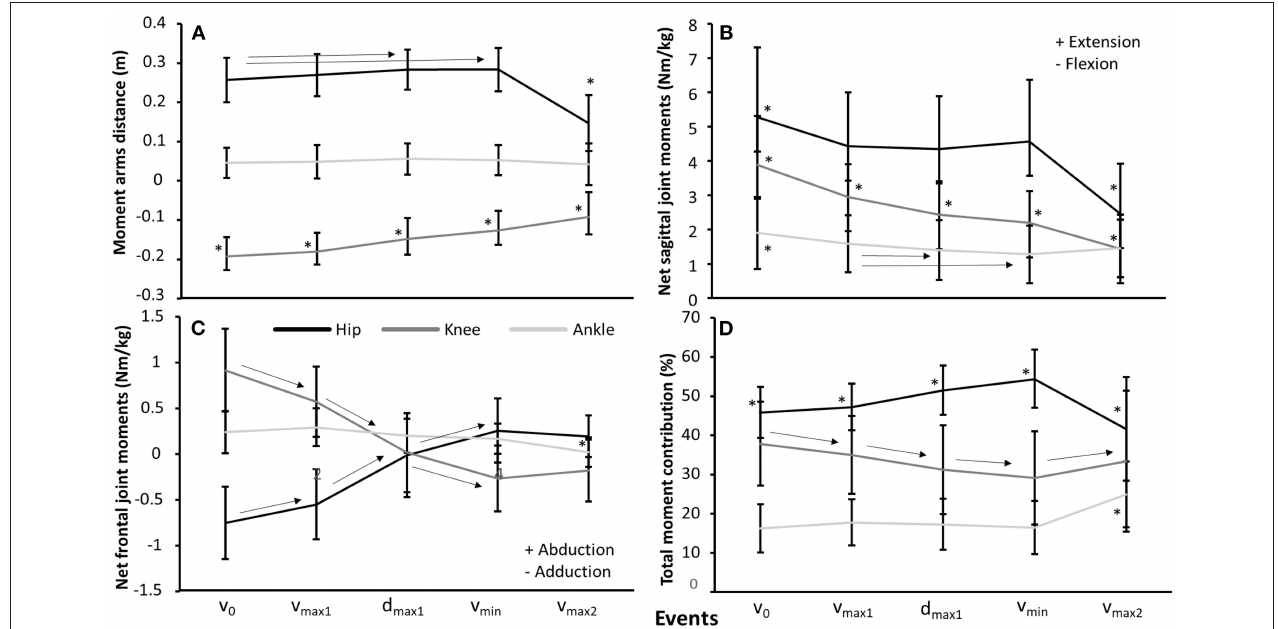
FIGURE 4 | Mean ± SD (A) moment arms, (B) sagittal net joint moments, (C) frontal net joint moments, and (D) net moment contribution to total net moment for the hip, knee, and ankle joints in the events v 0 , v max1 , d max1 , v min , and v max2 during the last repetition in 3-RM back squats. * indicates a significant difference from all other events on a p ≤ 0.05 level. → indicates a significant difference between these two events on a p ≤ 0.05 level.